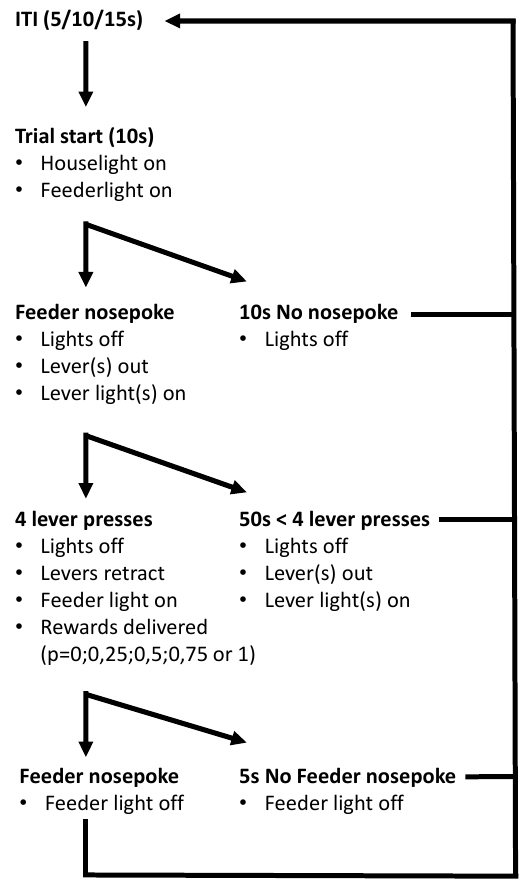
Figure 7. Flow chart of a trial on the probability discounting task (ITI: Intertrial